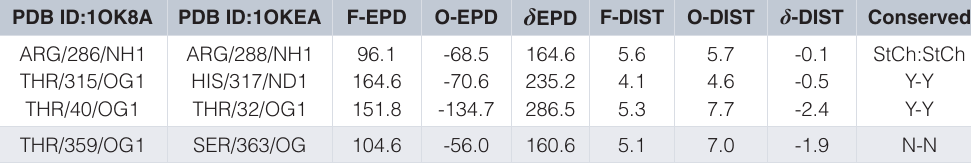
Table 1. Residue pairs with reversal in electrostatic potential difference (EPD) in the post-fusion DENV2 E-protein. These pairs have minimal distance perturbation (<4 Å), significant reversal in EPD (> 150 units) and are within 8 Å in both conformations. For example, Arg286-Arg288, part of a cationic β -sheet and a putative GAG-binding domain, has an electrostatic perturbation without having any relative spatial displacement. F-: final value in post-fusion DENV-E protein (PDB ID:1OK8A), O-: original value in pre-fusion DENV-E protein (PDB ID:1OKEA). Conserved in ZIKV and all four DENV serotypes? - Y: yes, N: no, StCh: stereochemically equivalent. Distances in Å. See Methods section for units of